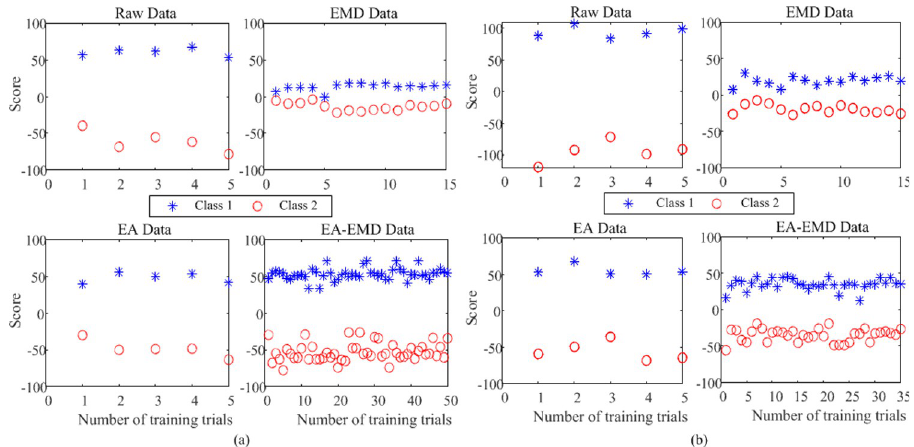
Fig 4. Taking five raw training trials per class as an example for building the classification model, the classification scores of raw data, EA data, EMD data, and EA-EMD data derived from (a) subject A3T in data set 1 and (b) subject S5 in data set 2. EMD data and EA-EMD data are the expended data including artificial data generated by EMD in the case of the best multiple of artificial frames, which are 2 and 9 respectively for Fig 4(A) respectively and 2 and 6 respectively for Fig